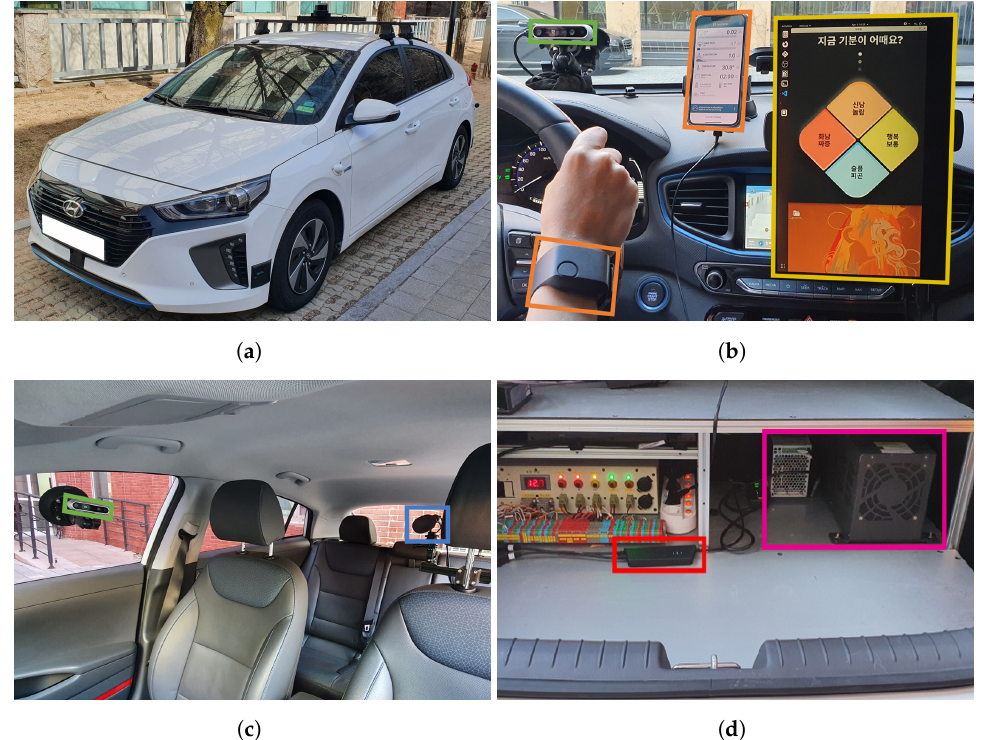
Figure 2. Figures of the dataset collection system hardware interface build in the vehicle. ( a ) Vehicle exterior; ( b ) Inside view of the vehicle center fascia; ( c ) Inside view of the vehicle passenger seat; ( d ) Vehicle trunk. Two cameras are installed to collect the image data of a driver’s face and posture (green). A microphone is installed on the right side of the driver seat’s headrest to collect audio data in the cabin (blue). Wristband-type wearable sensor is worn on the driver’s wrist to collect the driver’s bio-physiological data, and the collecting status can be monitored through a smartphone (orange). The CAN interface device supports the collection of vehicle CAN data (red). The monitor installed on the center fascia is a touch screen for interaction with the driver (yellow). The computer installed in the trunk of the vehicle integrates the collected data (magenta).